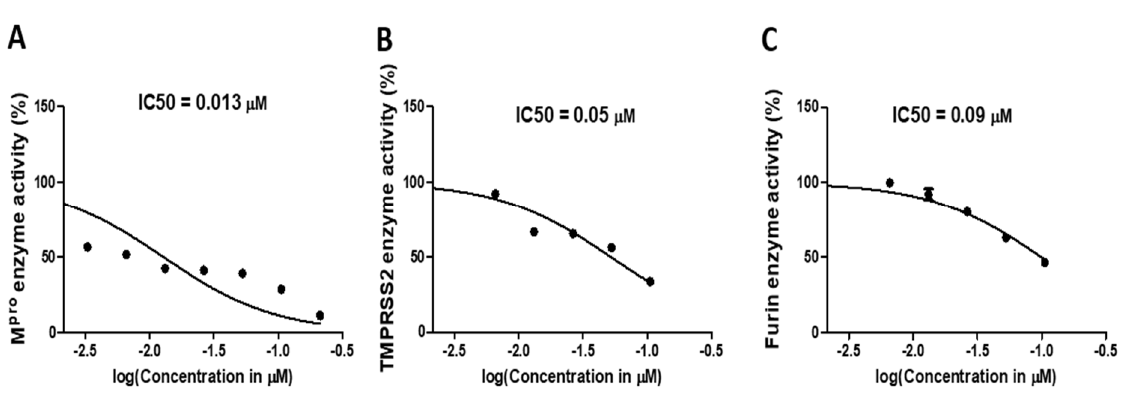
Figure 6. Inhibition activity of M3 against selected critical SARS-CoV-2 targets. ( A ). IC 50 calculation of M3 against SARS- CoV-2 M pro enzyme. ( B ) IC 50 calculation of M3 against human TMPRSS2 enzyme. ( C ) IC 50 calculation of M3 against human furin enzyme. The data display the mean of the percentage of the enzyme inhibition ± SEM of 3 replicas.